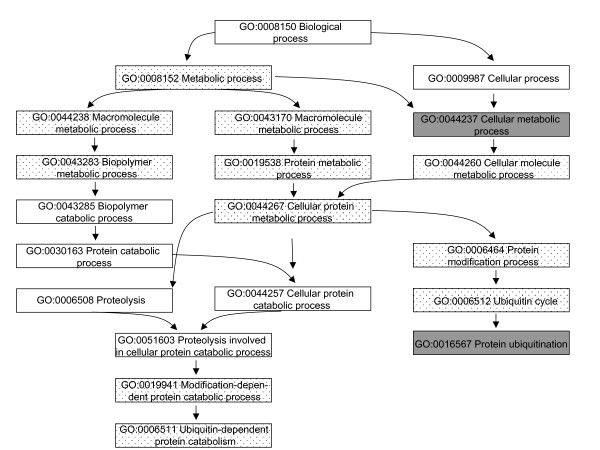
Protein ubiquitination related differentially regulated processes. The dotted boxes represent GO terms that were down-regulated in both the normal and the tumour tissues of the exposed patients in comparison to the non-exposed using both the t-test and fold change based ranking. The grey boxes represent GO terms that were down-regulated using at least one of the tests.